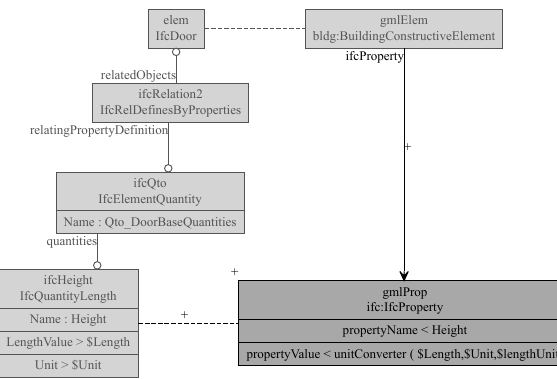
Figure 10. A rule extracting the height quantity from IfcDoor, converting it to meters using the $lengthUnit variable and setting it as a new IfcProperty node with the name DoorHeight in CityGML.